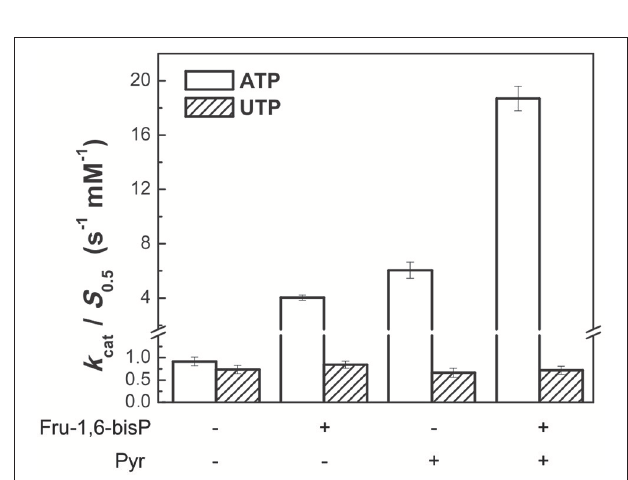
FIGURE 3 | Activators effect on ADP-Glc PPase catalytic efficiency. Activity was measured when the enzyme used alternative ATP (white bars) or UTP (oblique line bars) as substrate in presence of allosteric effectors. Error bars are SD of three independent sets of data.